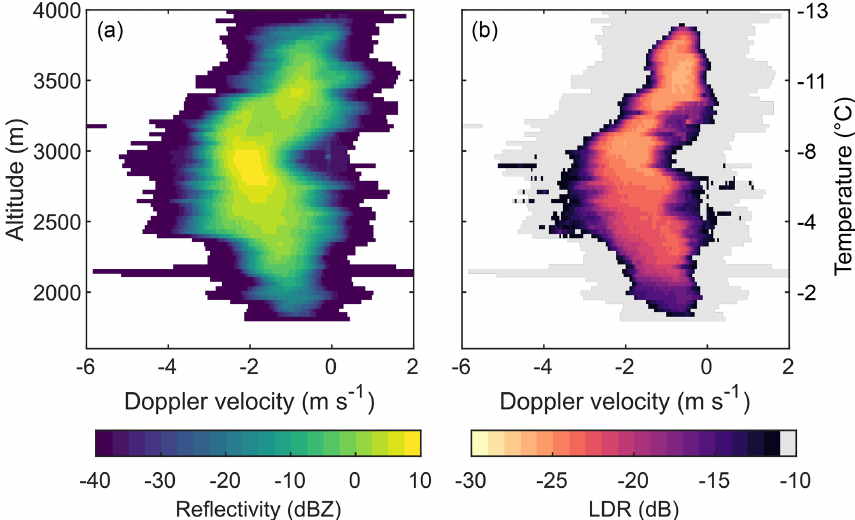
Figure 10. Vertical profile of the radar reflectivity (a) and LDR (b) Doppler spectra along the LDR fallstreak at 18:00UTC averaged over 1min (see red line in Fig. 3d). LDR values larger than − 10dB are shown in gray. The temperature profile measured by the radiosonde is shown on the right y